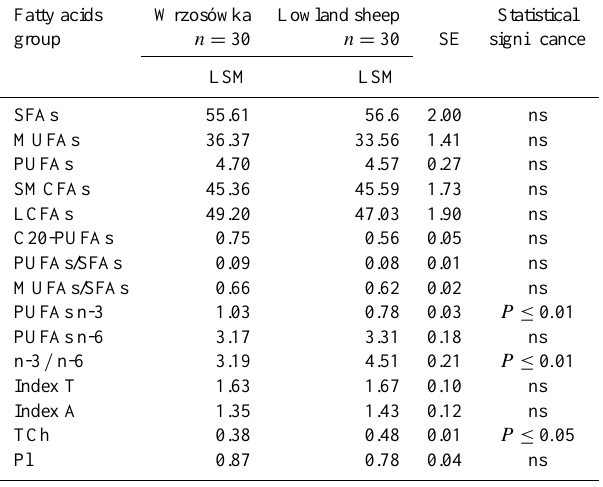
Table 5. The content of main groups of fatty acids (g100g − 1 fat), the content ratios of PUFAs, MUFAs to SFAs, the content ratio of PUFAs n-3 to PUFAs n-6, and the content of cholesterol and phos- pholipids (g100g − 1 fat)in milk of examined sheep